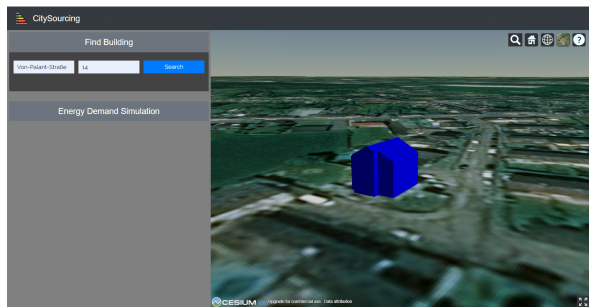
Figure 5. User interface of the CitySourcing application.